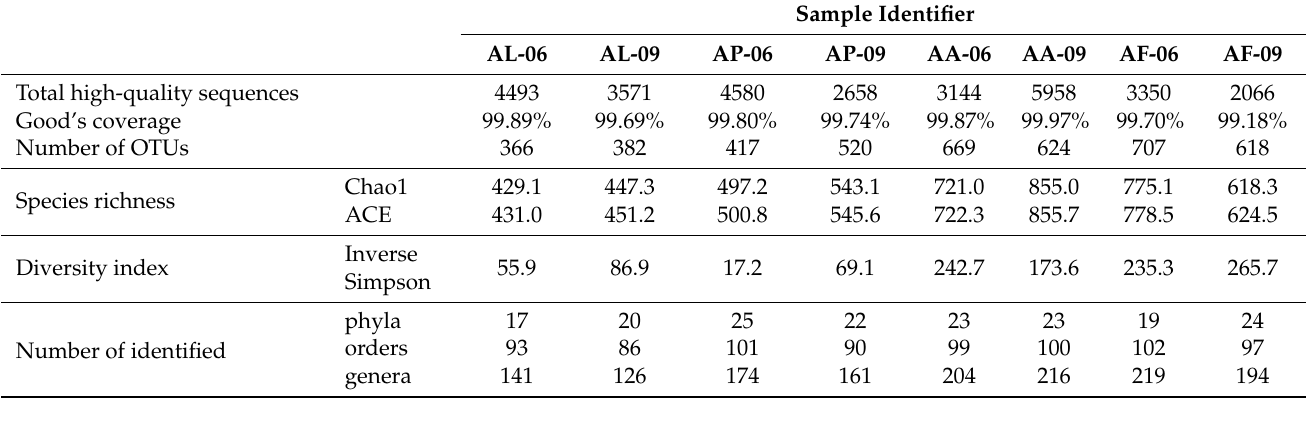
Table 3. Pyrosequencing read numbers, coverage, OTU numbers, richness estimators, diversity index and number of different taxa for bacterial communities from the sodic soil samples originated from different alkali vegetation types. Sample identifiers are presented in Table 1.